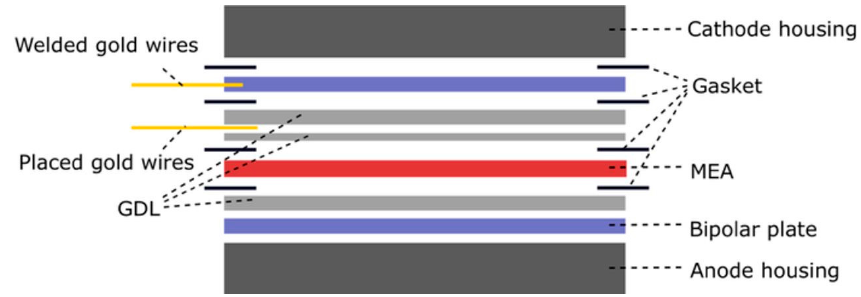
Figure 6. In situ contact resistance measurement according to Lædre [65].